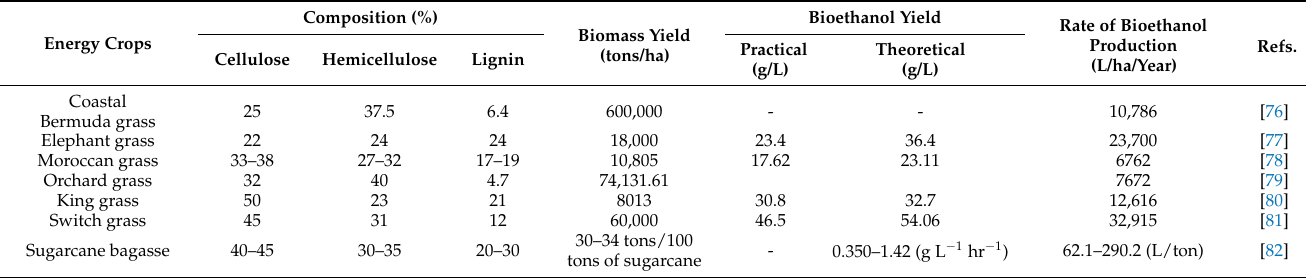
Table 5. Composition and bioethanol production from some of the commonly used crops.